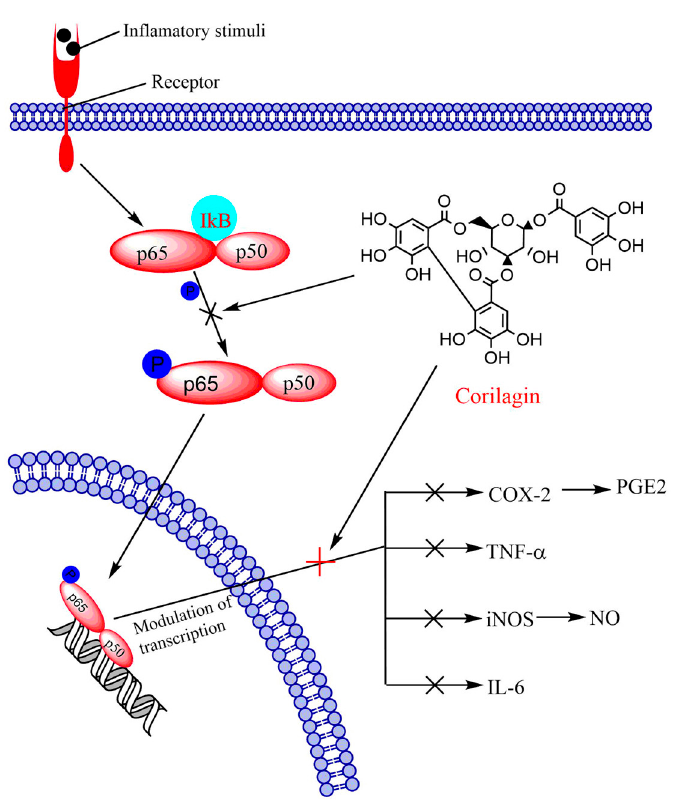
Figure 2. The effect of corilagin on NF- κ B and related pathway in neural cancer. Figure 2. The e ff ect of corilagin on NF- κ B and related pathway in neural